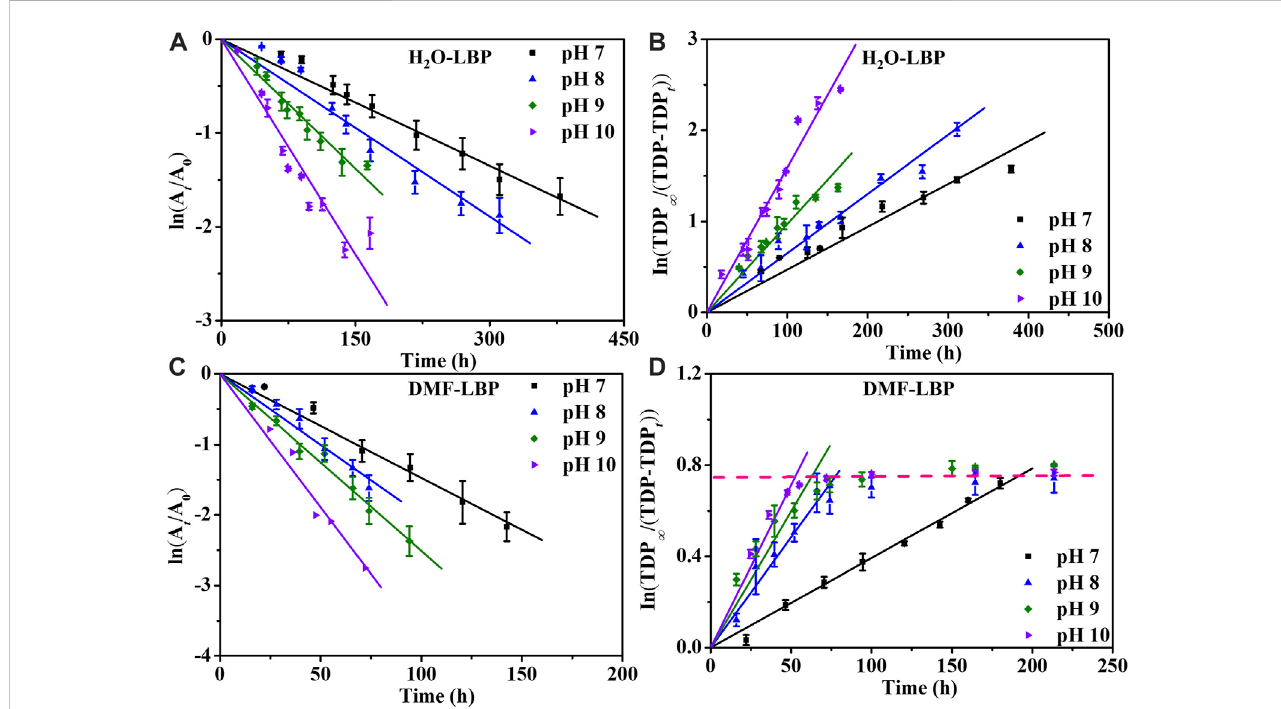
Degradation kineticscurves ofLBPbasedonUVabsorbance (A,C) andbasedonTDP (B,D) atdifferentpHunder37 ° C±1 ° C.A 0 andA t :UVabsorbanceat time 0 and t ; TDP ∞ : total concentration of P in LBP; TDP t : TDP at time t